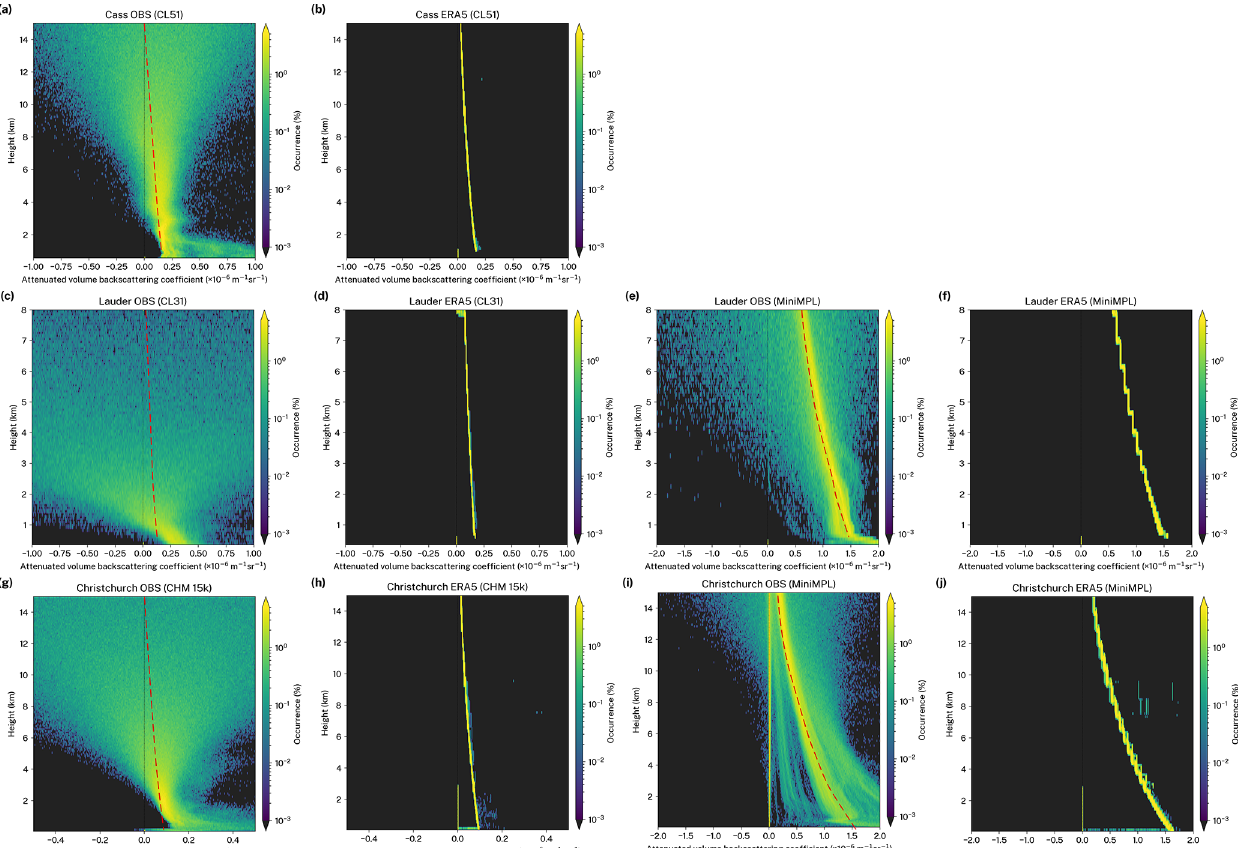
Figure 8. The same as Fig. 7 but calculated from clear-sky profiles